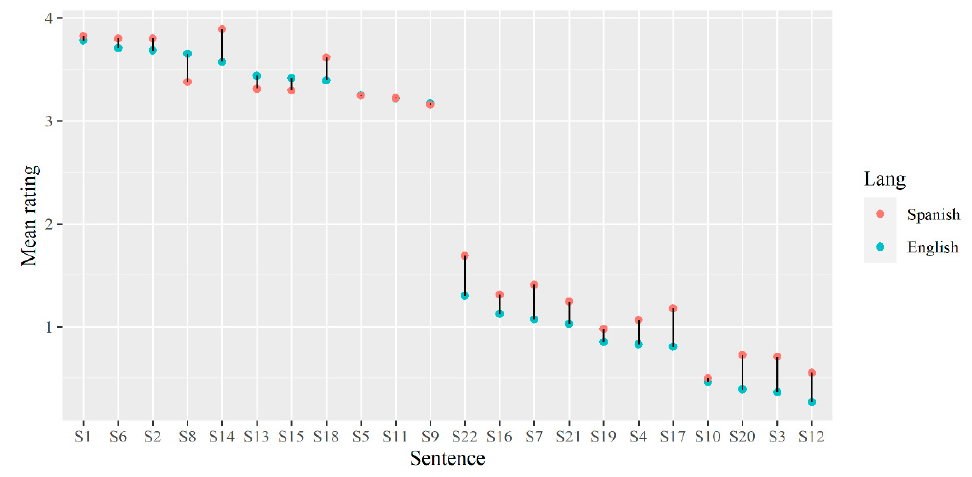
Figure 1. Average rating for emotional sentences by language.